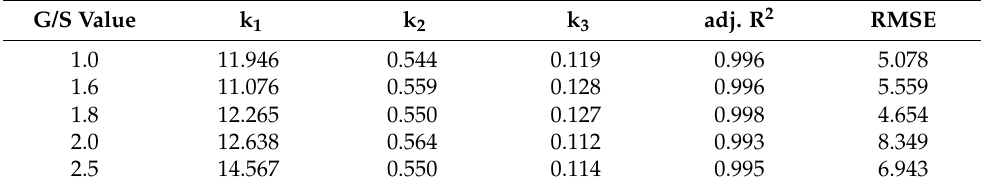
Table 7. Regression parameters k 1 , k 2 , and k 3 of resilient modulus prediction model No. 4 for different